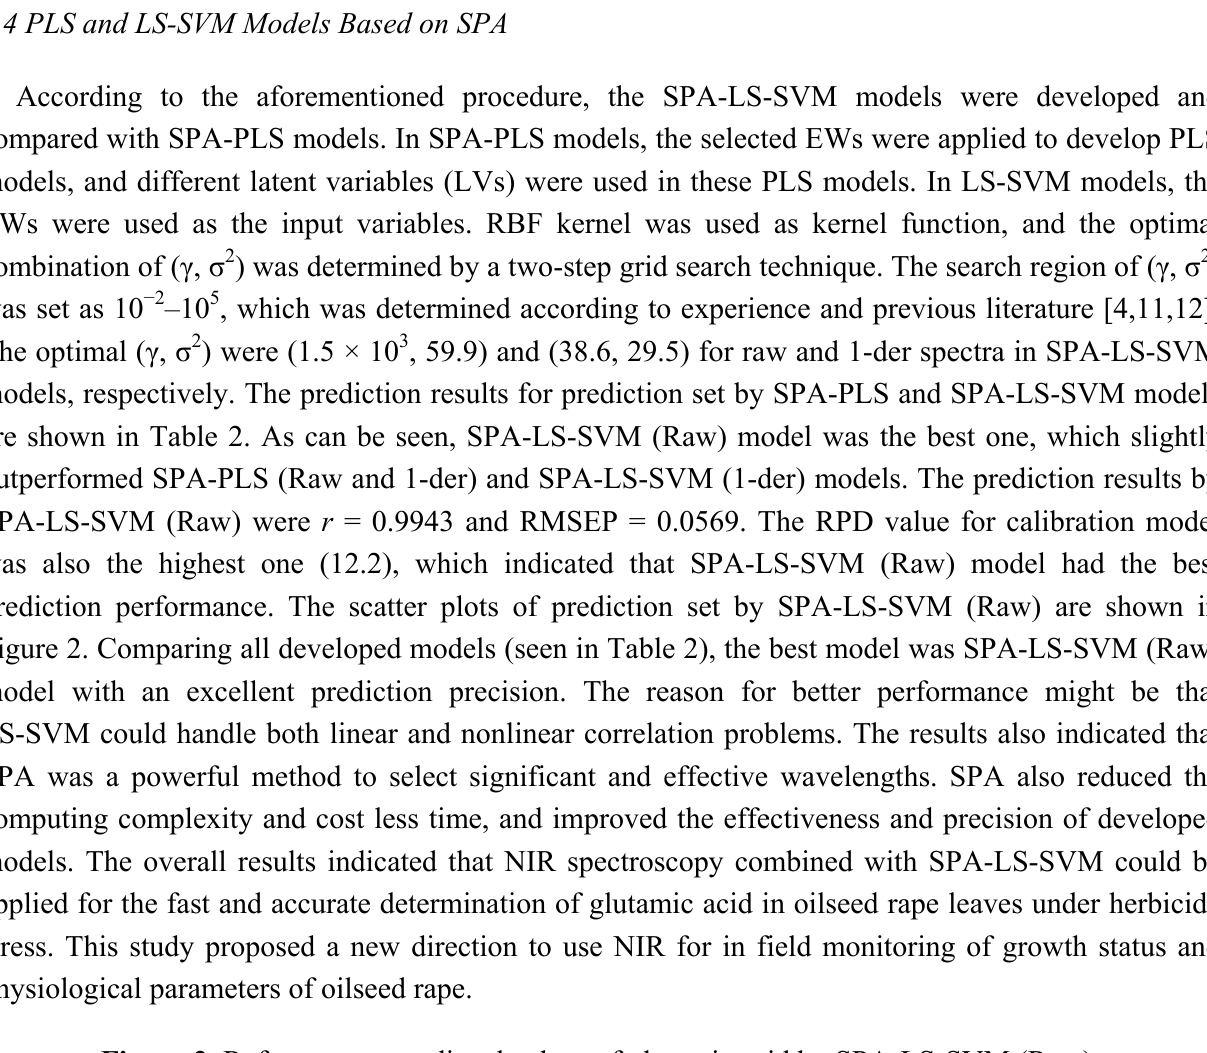
Figure 2. Reference vs. predicted values of glutamic acid by SPA-LS-SVM